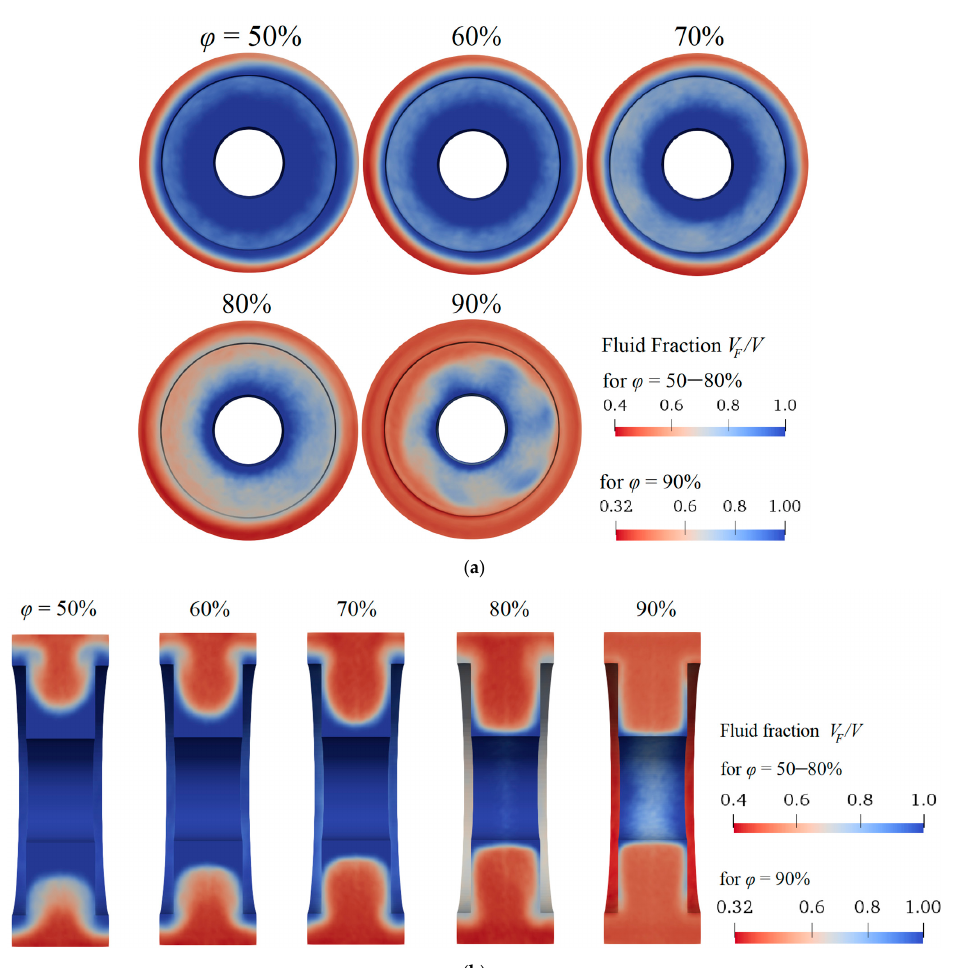
Figure 3. Local grinding media concentrations for different total filling levels: ( a ) in radial plan view; ( b ) an axial cut at y = 0. The scale shows the volumetric fluid fraction, where a fluid fraction of 0.4 implies a local grinding media filling of 100%, assuming a bulk porosity of ε = 0.4.